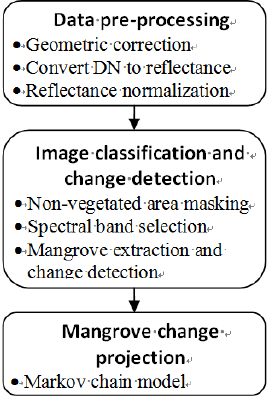
Figure 3. Flowchart of the methodology used for investigating mangrove forests in the study